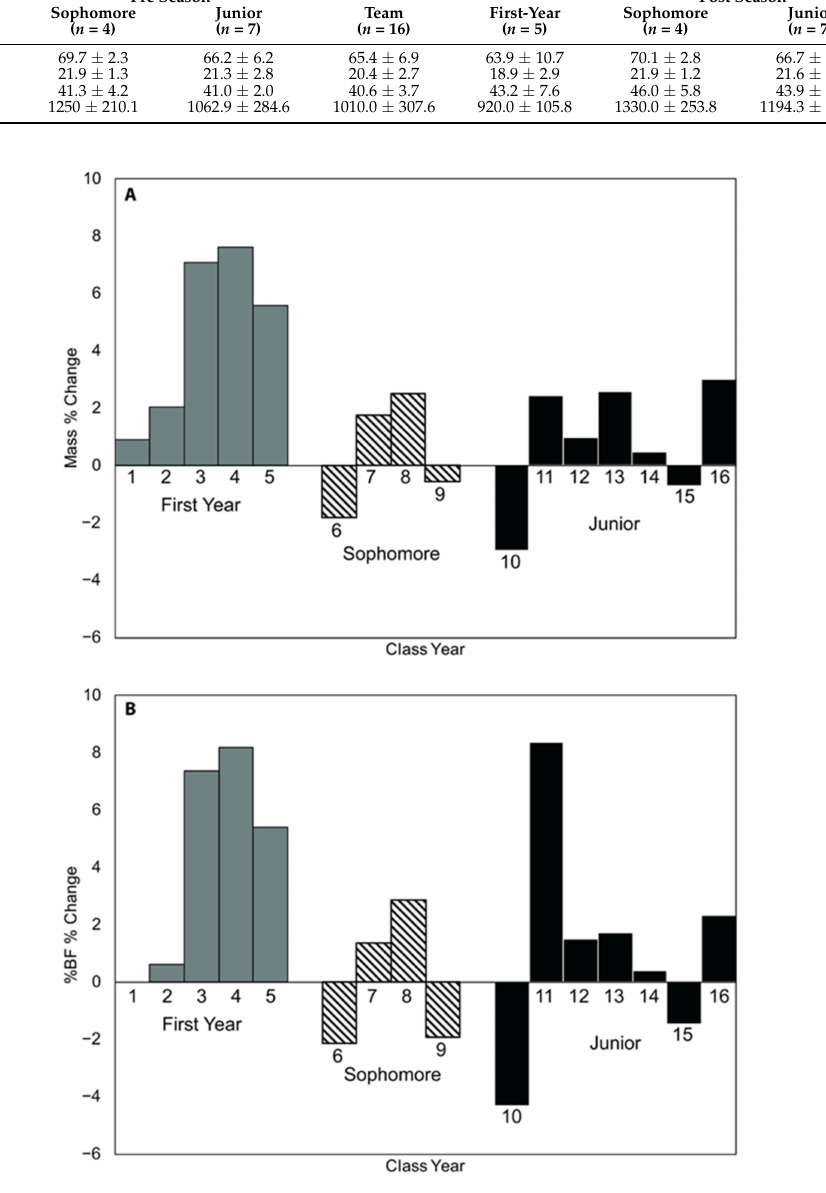
Figure 2. Percent change from pre season to post season for each individual player, grouped by class year for ( A ) mass and ( B ) percent body fat. Vertical jump height for all athletes improved pre to post season an average of 8.9 ± 7.0% (F 1,13 = 22.900, p < 0.001, η p2 = 0.638). First-year athletes, on average, performed worse on the vertical jump during both the pre and post season compared to sophomores and juniors, though there was no significant main effect of class year (F 2,13 = 2.610, p = 0.111, η p2 = 0.287) or interaction effect (F η p2 = 0.067) on vertical jump. All 2,13 = 0.463, p = 0.639, but one athlete, a junior, improved or maintained their jump height post season. The largest gains were seen in the sophomores who increased an average of 11.5 ± 6.4%, compared to 9.2 ± 4.5% for the first-years and 7.2 ± 9.0% for the juniors (Figure 3A). The single largest percent change, 25.0%, occurred in a junior athlete. This player also had the largest absolute increase in jump height, 10.2 cm, where she went from having the fifth highest jump pre season to the third highest jump post